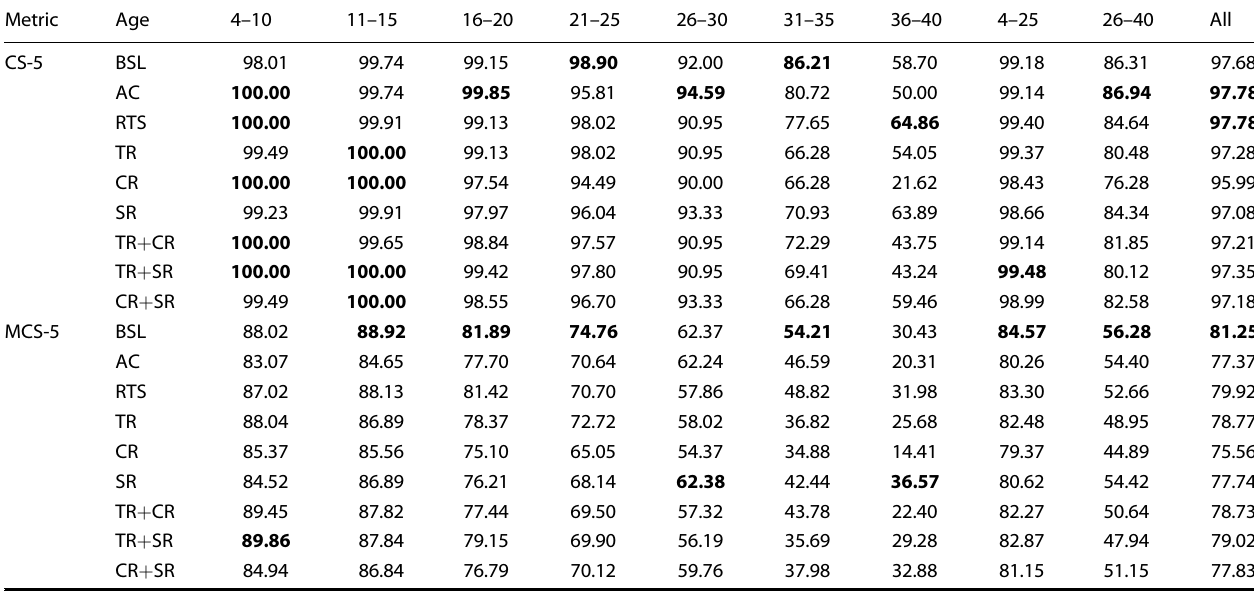
Table 2. Tabulated measurements results of the cumulative score-5 (CS-5) and mean cumulative score-5 (MCS-5) (%). Metric